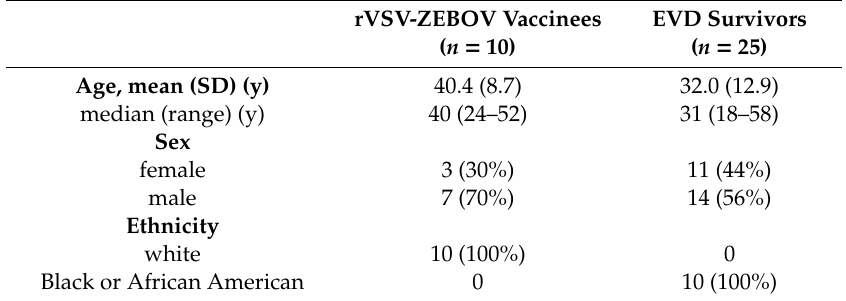
Table 1. Study cohort. Age, sex and ethnicity of rVSV-ZEBOV vaccinees at d0 and of EVD survivors on day of blood sampling are shown. Absolute numbers (%) are displayed unless otherwise